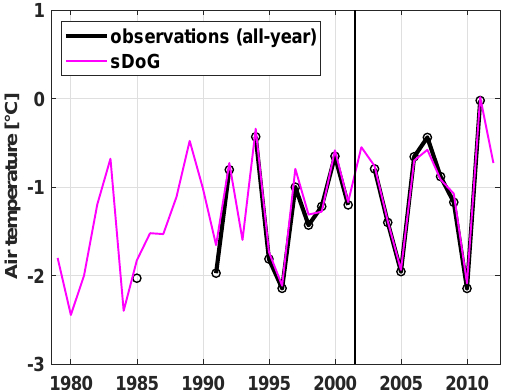
Figure 3. Annual mean air temperature at VERNAGT, observed (black) and modeled by sDoG (magenta) from 1979 to 2012. Note that due to data gaps in winter, observed values are missing particularly prior to 1990. The black vertical line separates the true evaluation period (1979 to 2001) from the training period (2002 to